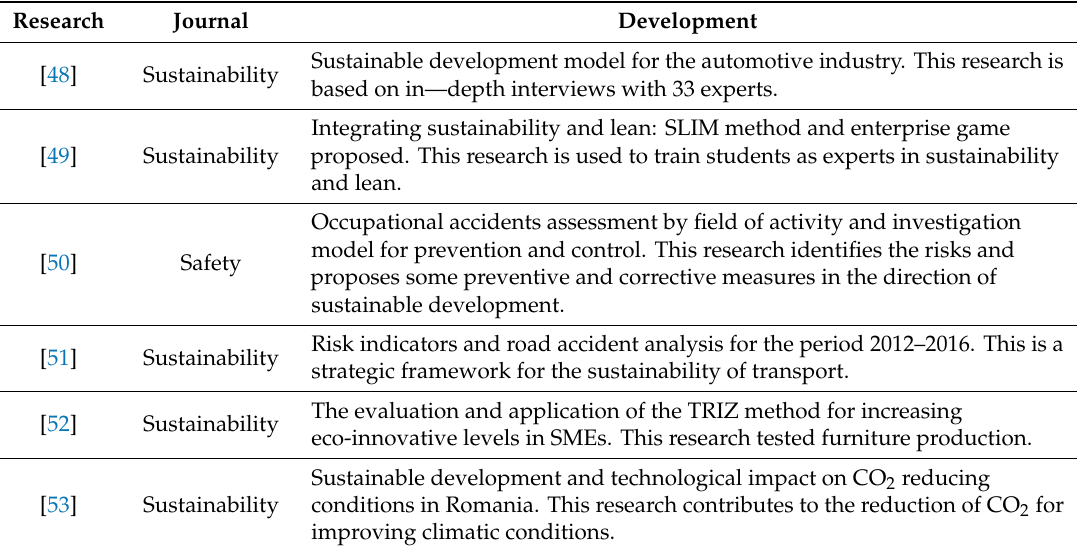
Table 3. Research by the author in the field of sustainability and innovation.